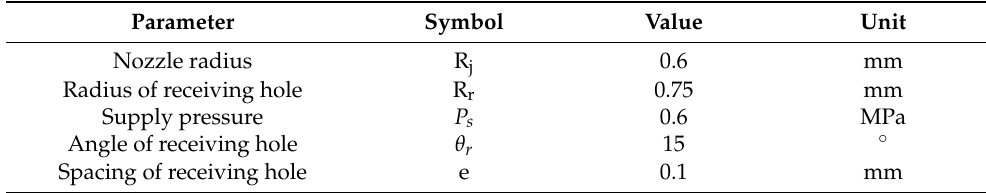
Table 3. Parameters value of a jet pipe valve.